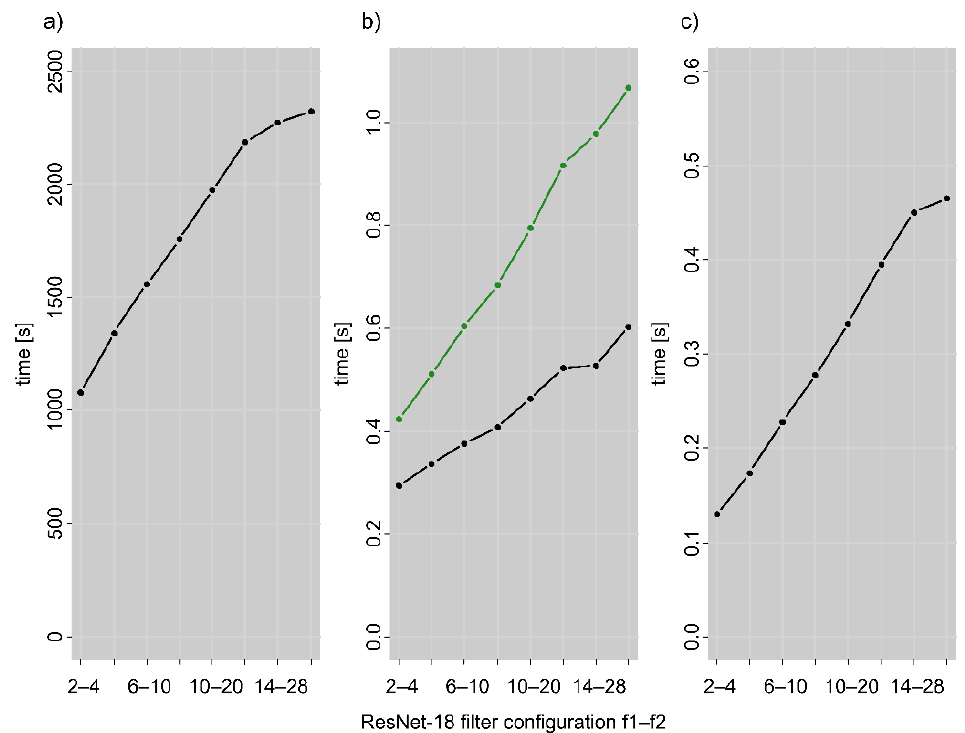
Figure 7. Evaluation speed for one UAV image in relation with filter configuration for the patch-level ( a ) and the image-level classifier ( b ) plus evaluation speed according to 16- or 32-bit resolution for the image-level classifier (16-bit—green line). In ( c ), the time difference between 16- and 32-bit resolution is shown for the image-level classifier. Model results for each filter configuration were aggregated from five model runs with different randomization (seeds) of the weights.